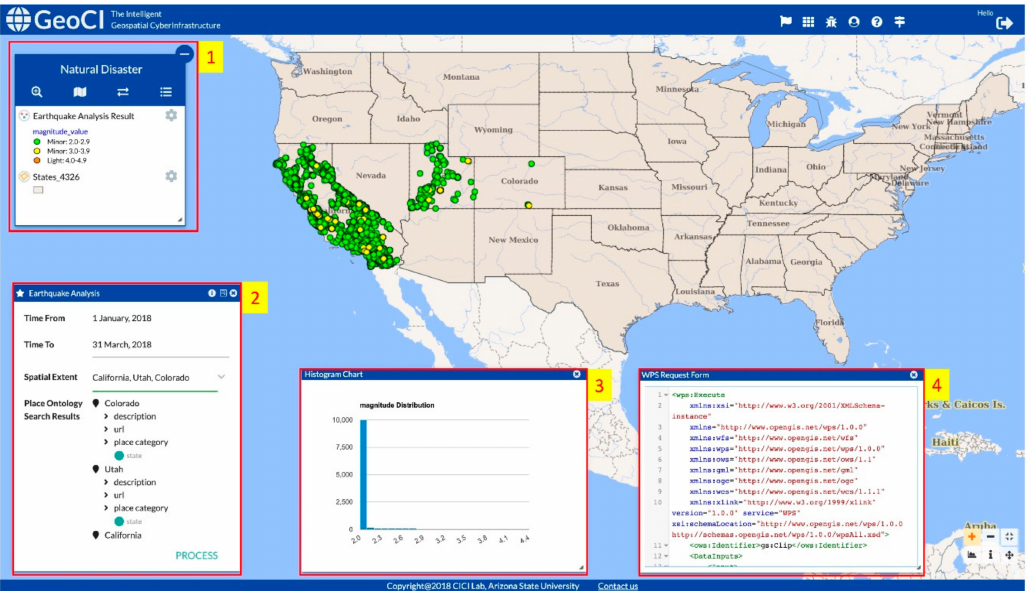
Figure 13. The interactive interface of the cyberinfrastructure portal (GeoCI). The “Natural Disaster” window (label 1) provides the workspace for Earthquake analysis. All data layers and results are displayed in this workspace. The “Earthquake Analysis” window (label 2) provides the interface to allow users to enter interested spatial and temporal constraints of a question on Earthquake in natural language. The window with title “Histogram Chart” (label 3) provides the statistics of the Earthquake data based on some attributes, i.e. magnitude. The executable workflow metadata is demonstrated in the “WPS Request Form” window (label